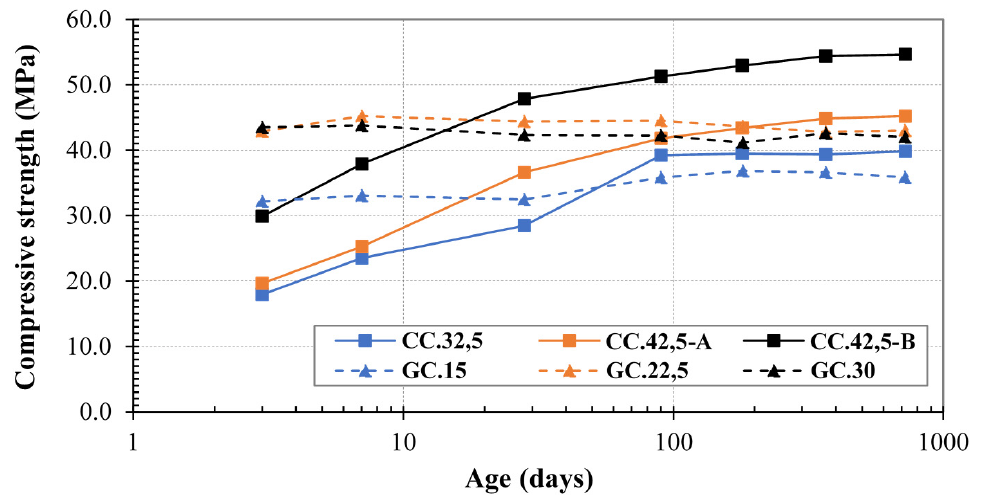
Figure 9. Compressive strength development of concretes. Table 4. Classification of concretes (EN 206-1) with respect to their compressive strength at 28 days (CC) and 7 days (GC). Experimental modulus of elasticity ( E cm ) and Poisson ratio ( v ) of